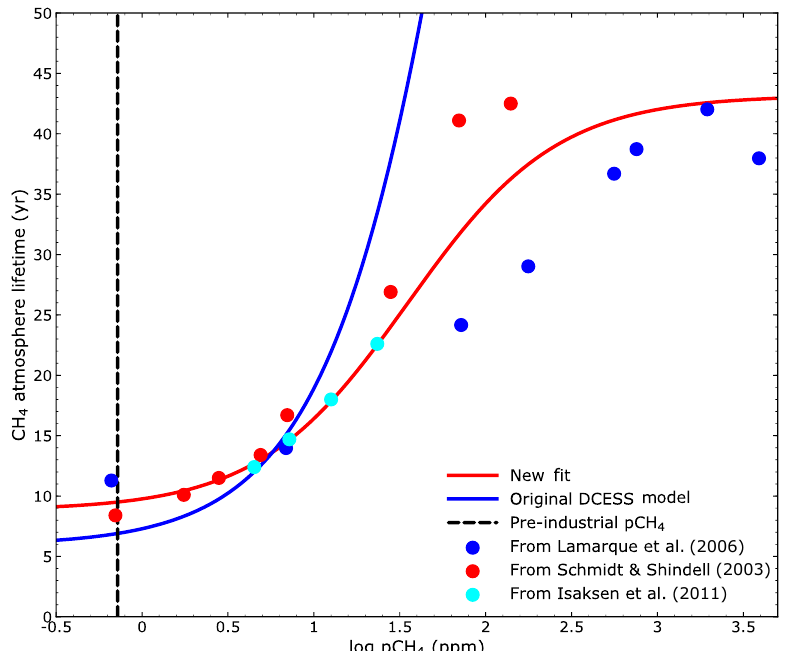
Figure 4. Atmospheric lifetime of methane as a function of atmospheric methane concentration. See text for a discussion of the model results and the functional fit to